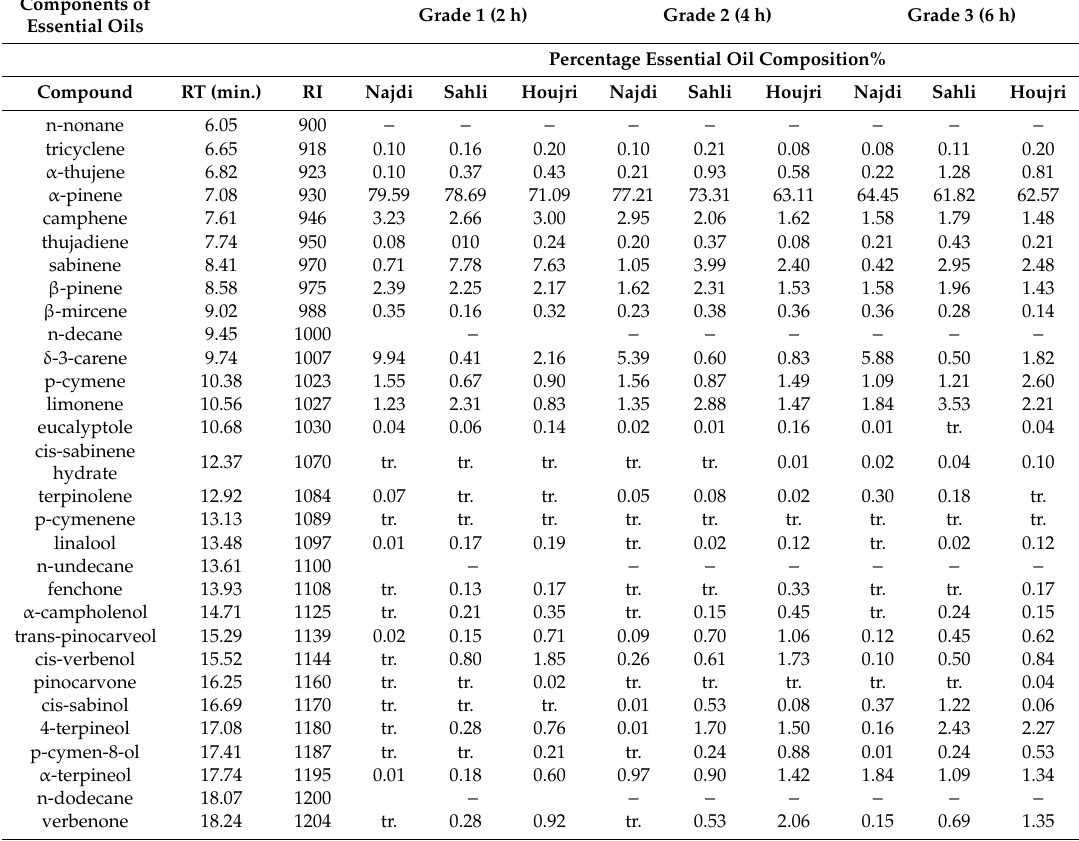
Table 2. Chemical constituents identified in Grade 1, 2 and 3 (respectively 2, 4 and 6 h hydrodistillation time) oleogum resin essential oils. RI = retention index relative to C8–C36 n -alkanes on ZB-WAX column, MS = NIST and Wiley library and the literature, tr. = trace ( < 0.01%). Components of Essential